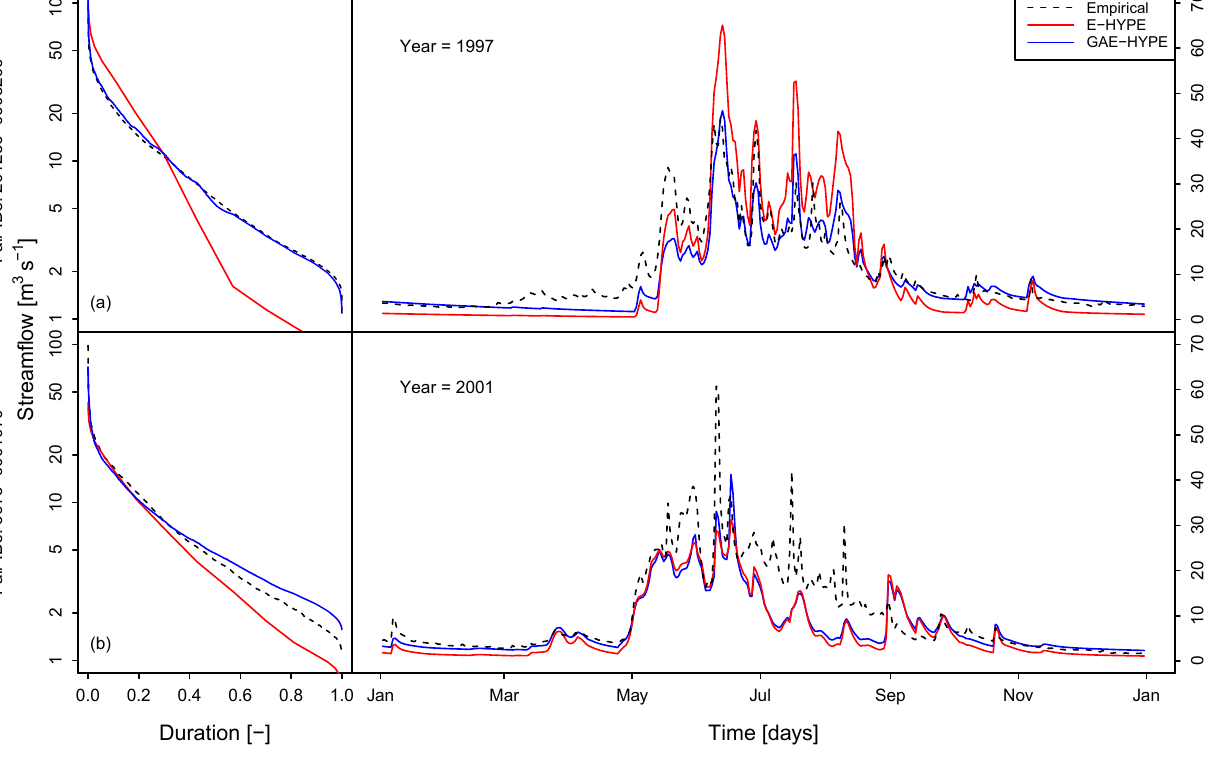
Figure 8. Examples of comparison between observed streamflow series (black dashed lines) and simulated daily streamflows via E-HYPE (red solid lines) and GAE-HYPE (blue solid lines) for two representative sites and a given year, showing two cases for which the geostatistical assimilation procedure resulted in sizeable (a) and limited (b) improvements,